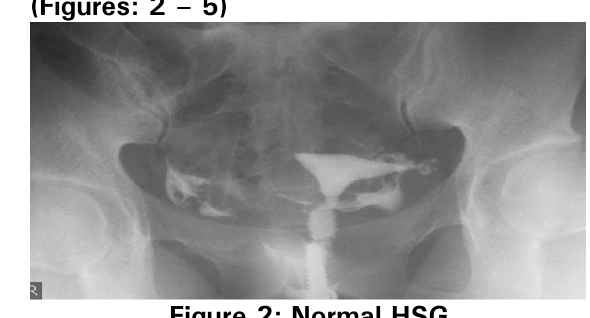
Figure 2: Normal HSG